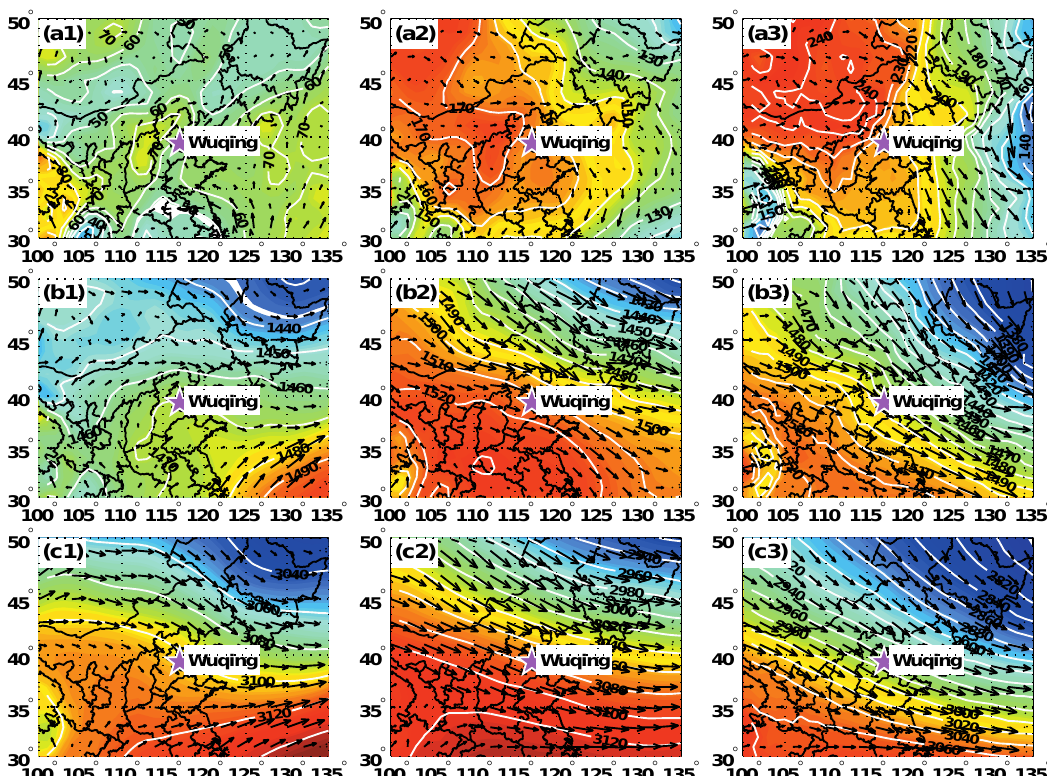
Fig. 2. Average Geopotential Height Field (white lines) and Wind Field (black vectors) for 1000hPa, 850hPa and 700hPa (indicated respectively by a, b, c ) for summer (9 July 2009–31 August 2009), fall (1 September 2009–30 November 2009) and winter (1 December 2009–21 January 2009) (numbered as 1, 2, 3) from NCEP FNL (Final) Operational Global Analysis data. The magenta star marks the location of the observation